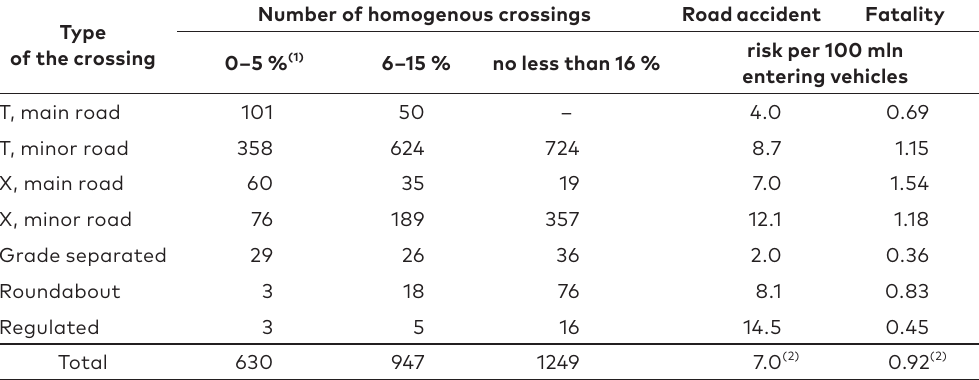
Table 2. Data on the groups of homogenous road